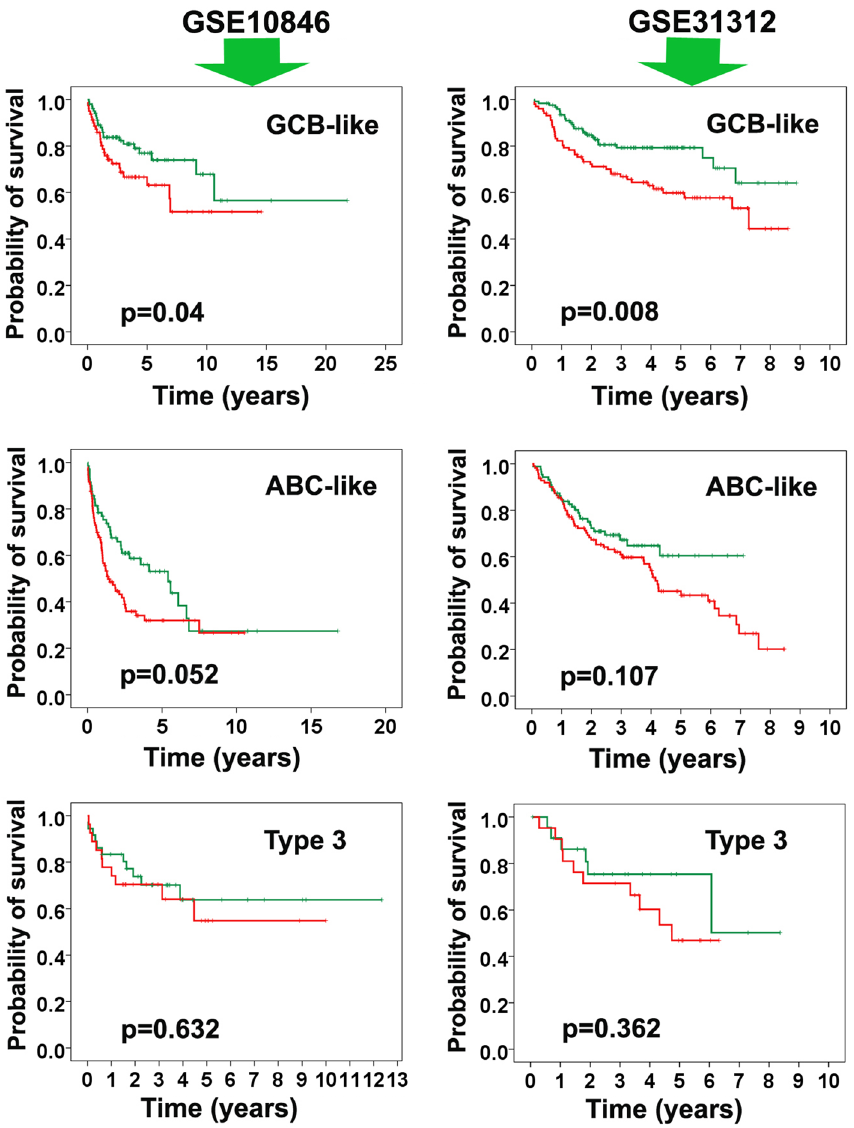
Figure 3. Comparison of expression of our predictor gene ( RTN1 ) in three molecular subtypes of DLBCL (i.e. ABC-like, GCB-like, and type 3). Left and right panels indicate GSE10846 and GSE31312 datasets, respectively. The survival time in GCB-like was significantly different between two risk groups ( Ps <